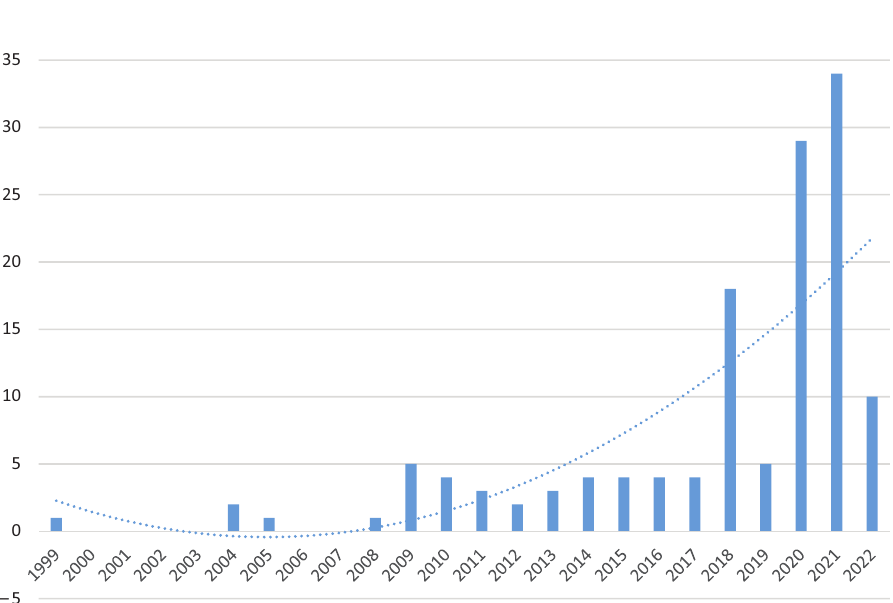
Figure 1. Number of publications in food security and short supply chain area,